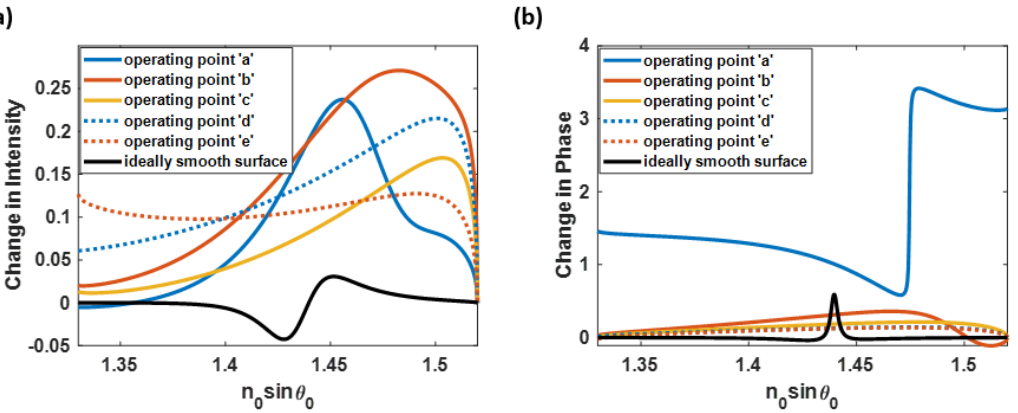
Figure 14. ( a ) Intensity detection and ( b ) phase detection of the operating point ‘a’, ‘b’, ‘c’, ‘d’, and the theoretically uniform surface SPR-based sensor.